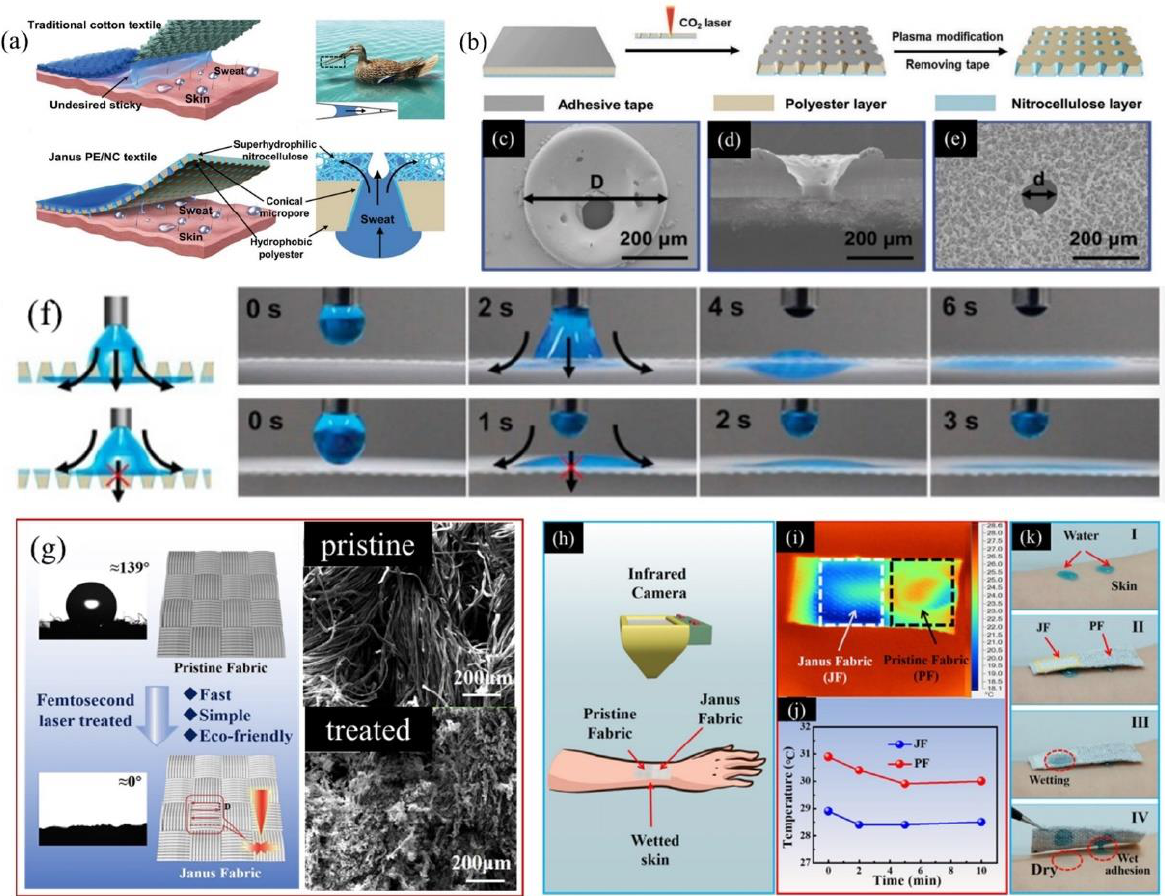
Figure 6. ( a ) Schematic comparison between sweat transport on skin by a traditional cotton textile and the Janus PE/NC textile that consists of conical micropores for efficient sweat liquid transport directionally. ( b ) Fabrication of the Janus PE/NC textile. ( c – e ) SEM images of the PE layer, cross- section, and NC layer of the Janus PE/NC textile. ( f ) Water drops onto the hydrophobic PE layer and penetrates it immediately; water drops onto the super-hydrophilic NC layer and spreads across its surface [52] (Copyright 2019, Wiley-VCH). ( g ) Fabrication of Janus fabric process, the water contact angle of the sample surfaces, an optical image of a water droplet on pristine fabric and Janus fabric, and SEM images of pristine fabric and laser-treated fabric. ( h – j ) The measured temperature of pristine fabric and Janus fabric on wetted skin. ( k ) Optical images of the quick liquid transport performance of the Janus fabric [53] (Copyright 2021, Applied Physics